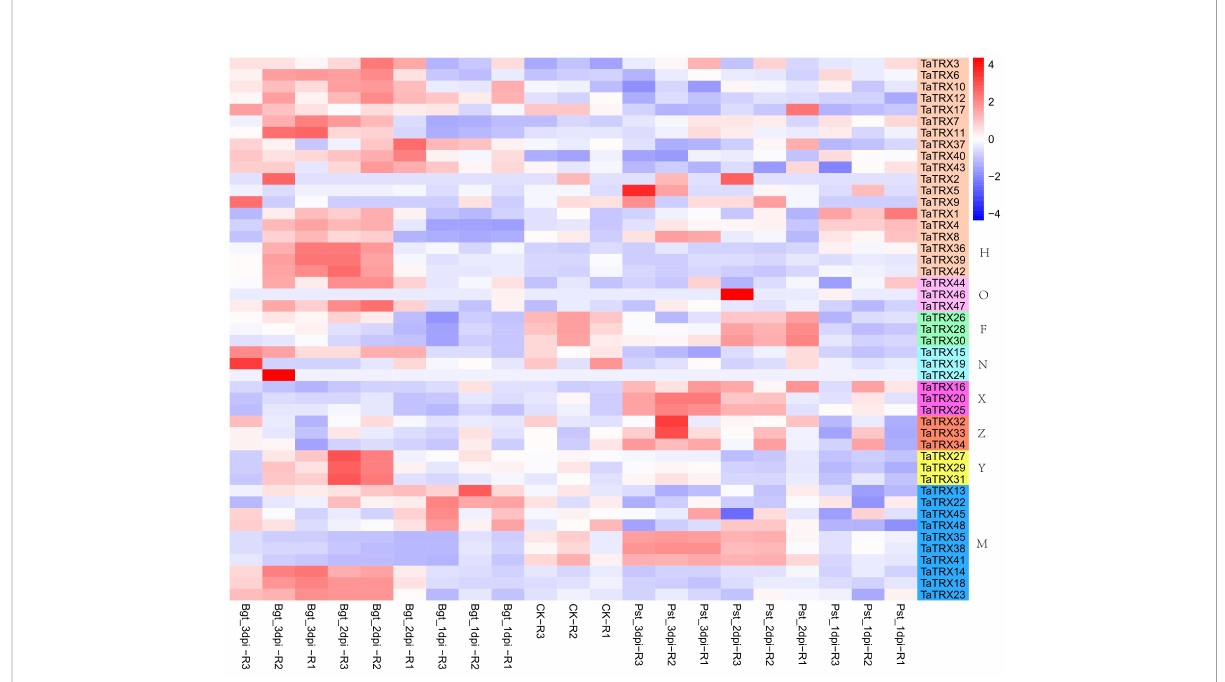
FIGURE 9 Expression pro fi les of typical TaTRX genes in wheat before and after the injection of powdery mildew and stripe rust. Bgt_1dpi, Bgt_2dpi and Bgt_3dpi represent 24h, 48h and 72h after powdery mildew pathogen was injected into wheat leaves; Pst_1dpi, Pst_2dpi and Pst_3dpi represent 24h, 48h and 72h after stripe rust pathogen was injected into wheat leaves; CK represents leaves not injected with powdery mildew and stripe rust. The red, white and blue cells represent the highest, medium and lowest gene expression levels, respectively. H, O, F, N, X, Z, Y, and M represent different subtypes of typical TaTRX genes, respectively. The colour scale represents Log2 expression